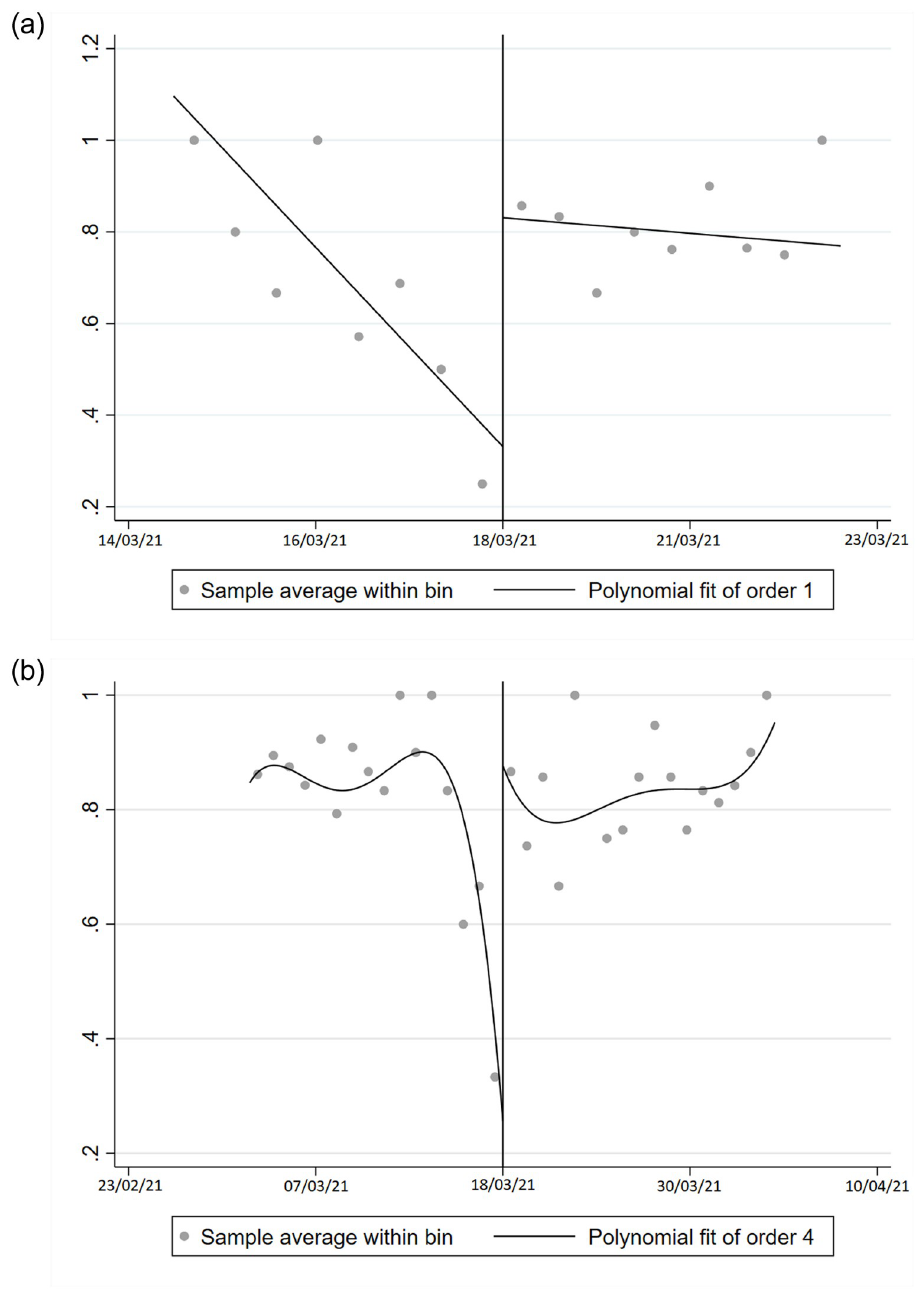
Fig 1. The impact of the EMA statement on the willingness to be vaccinated. Notes : These graphs show RDD plots for the dependent binary variable equal to 1 if the individual is willing to be vaccinated. Graph (a) is obtained using a local linear polynomial regression with triangular weights and bandwidth following the optimal mean squared error criterion in [16]. Graph (b) is obtained using a global -quartic polynomial and uniform weights. statement on the intention to be vaccinated of almost 50 percentage points. This effect is statis- tically significant at the 1% level and robust to different specifications. Considering the overall evolution of the outcome, the EMA statement was able to sharply invert the collapsing confi- dence observed in our data. This decline in intentions to be vaccinated in the pre-EMA period